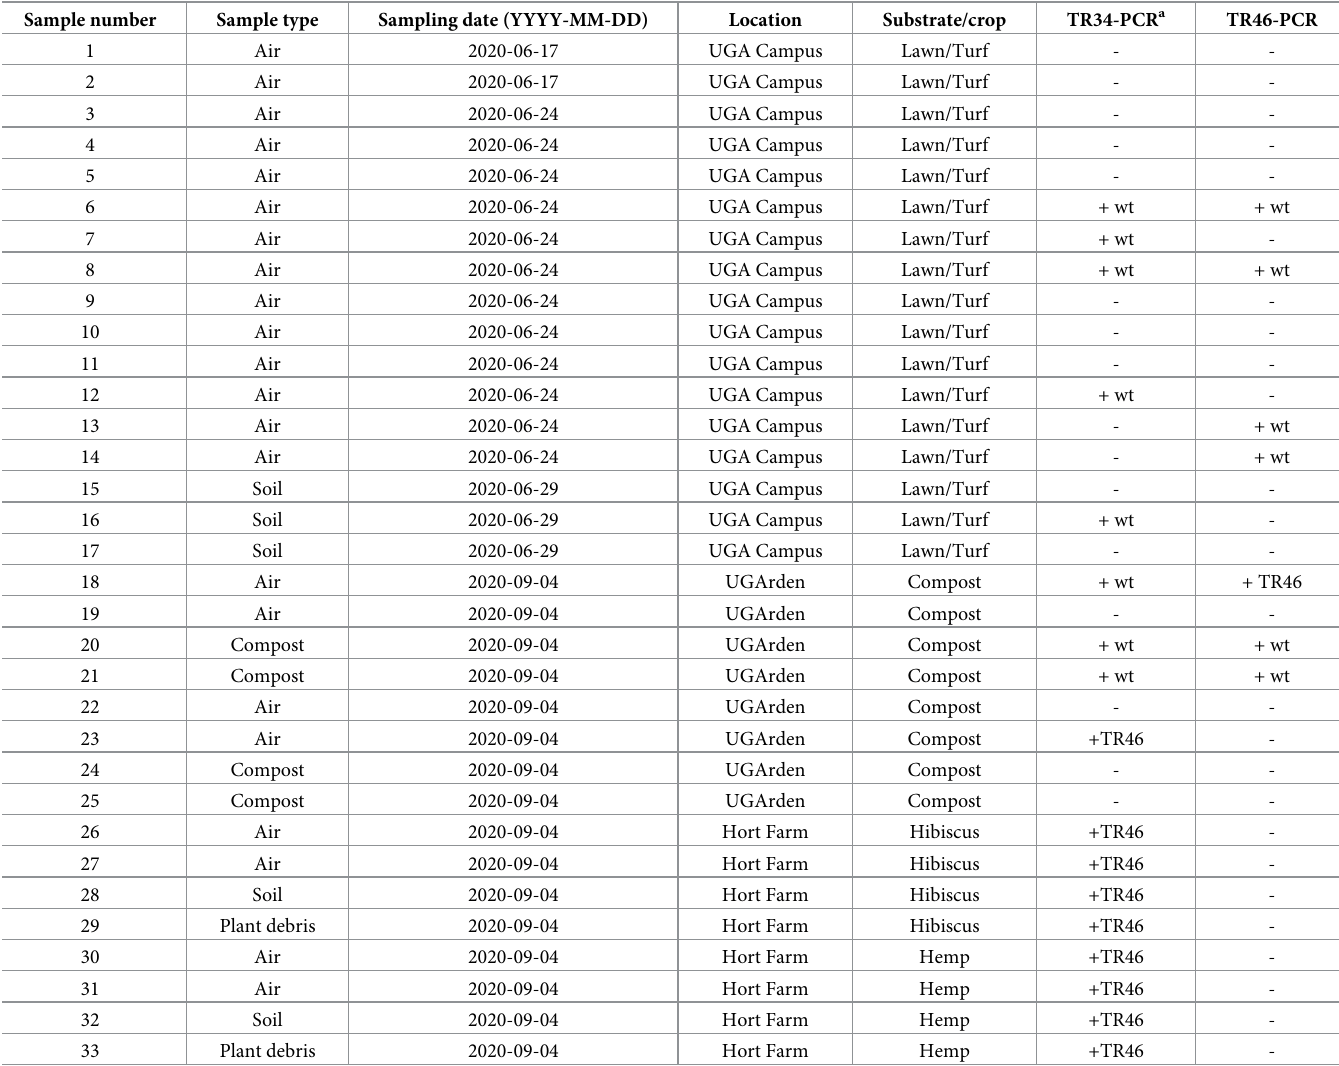
Table 1. Environmental samples and TR34-PCR and TR46-PCR assay